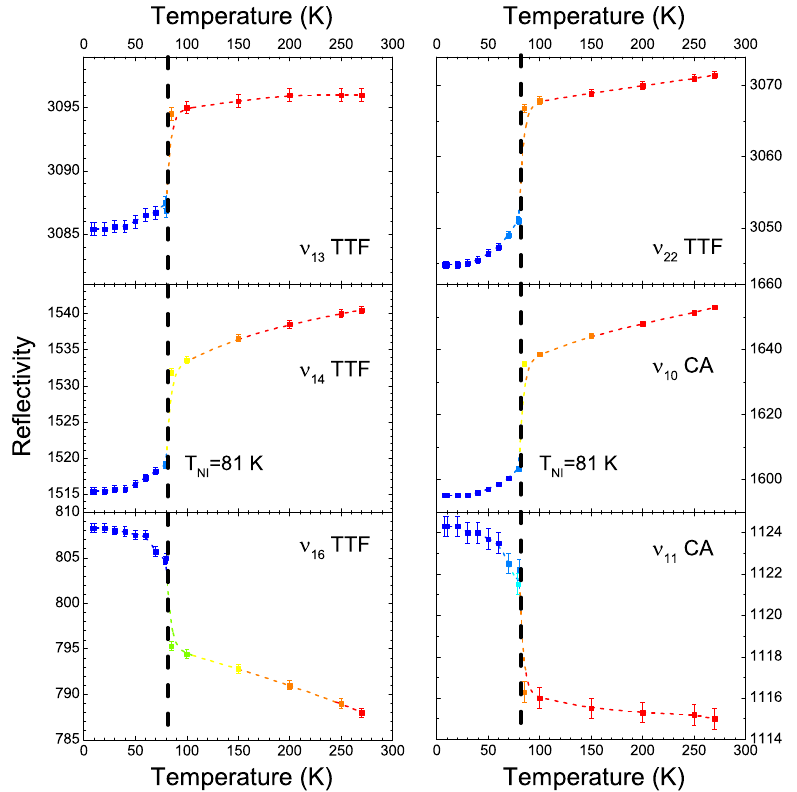
Figure 15. Temperature dependence of different vibrational frequencies observed from reflection measurements of TTF-CA with light polarized along the b -direction. In all cases, a pronounced shift—although in different directions—is observed at the neutral-ionic phase transition, with indications of fluctuations above and below T NI